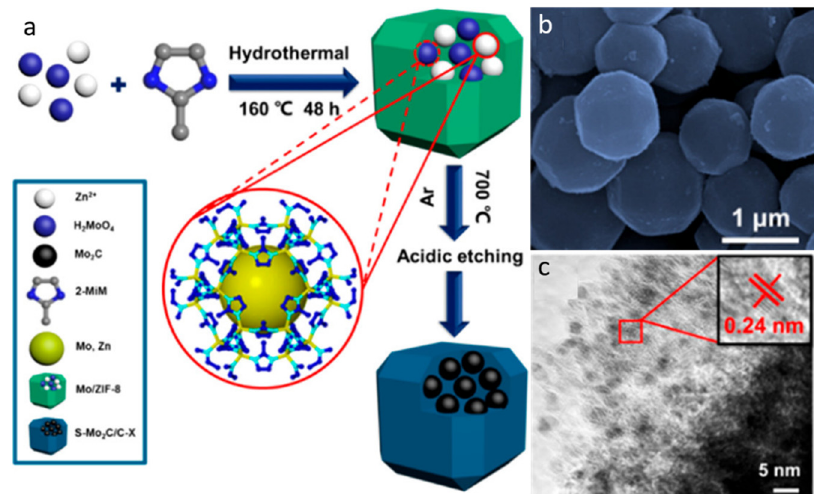
Figure 8. ( a ) Schematic for the fabrication of Mo 2 C-decorated carbon polyhedrons. ( b ) SEM micro- graph of the Mo 2 C/C, ( c ) and TEM micrograph of Mo 2 C/C with inset the HR-TEM micrograph of